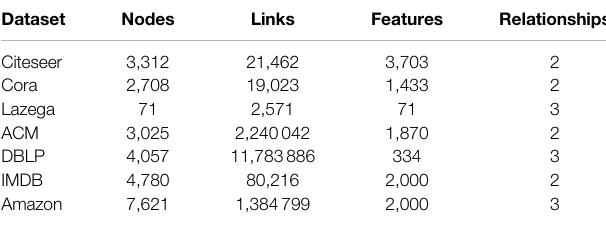
TABLE 2 | Dataset